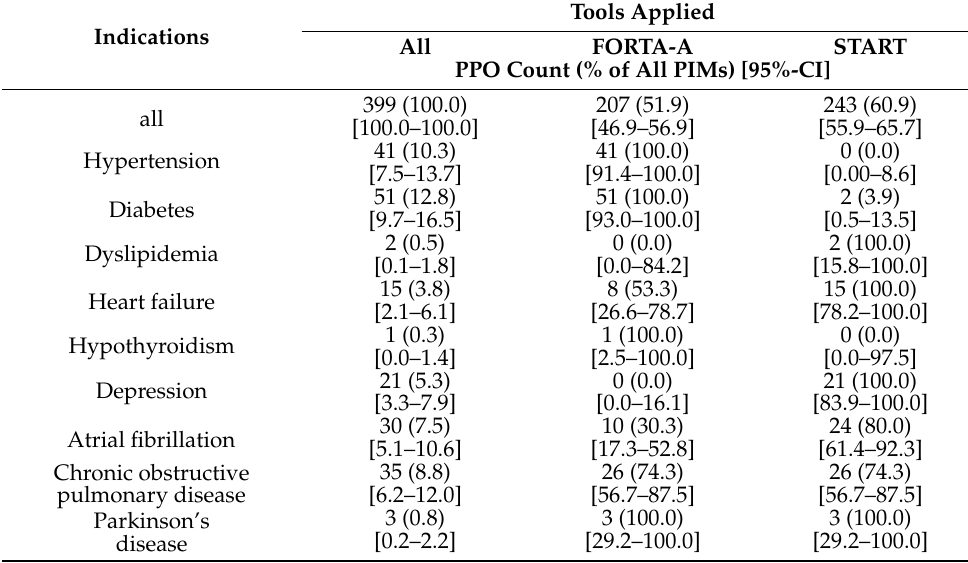
Table 6. Sensitivity of PPO detection for each tool, stratified by the most commonly implicated indications (accounting for 49.9% of all PPOs detected by any